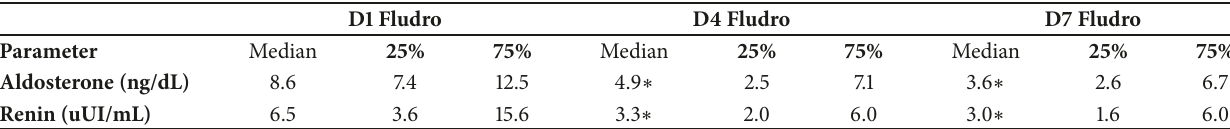
Table 3: La b oratory data during the fl udrocortisone phase. D1 Fludro, D4 Fludro, D7 Fludro = 1st, 4th, and 7th days of fludrocortisone, respectively. Data expressed as median and interquartile range (25th and 75th percentiles), compared by Friedman test followed by Dunn’s test. ∗ p < 0.05 vs. D1